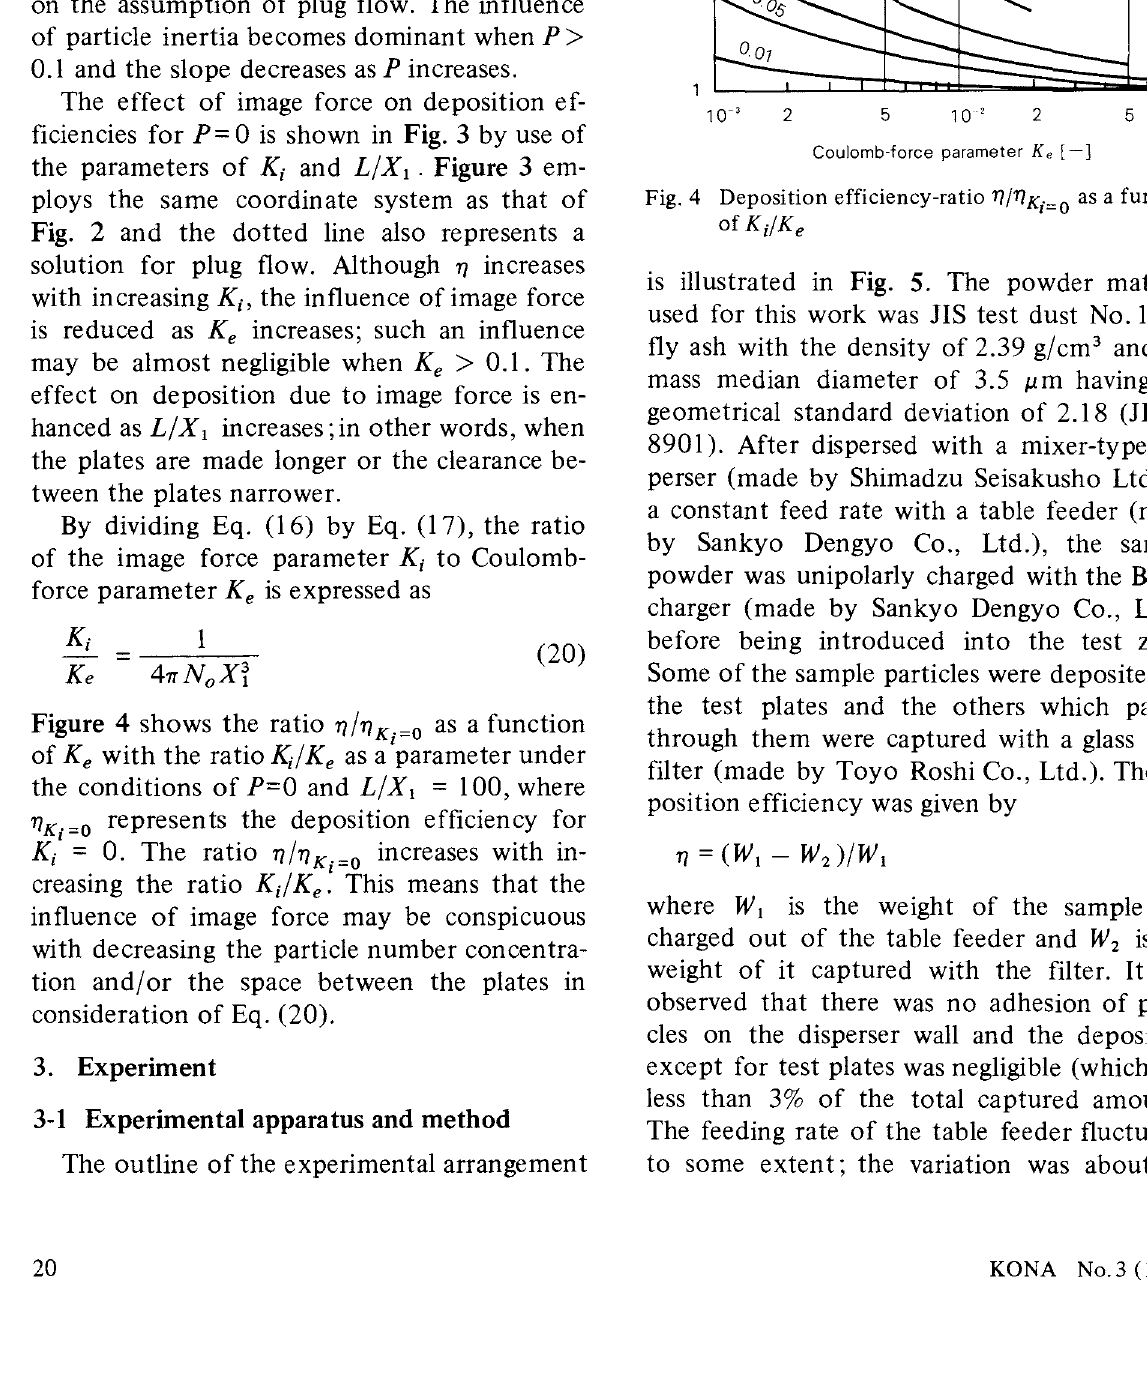
Fig. 3 Effect of image force parameter Ki on the deposition efficiency (as a function of Coulomb force parameter Ke)